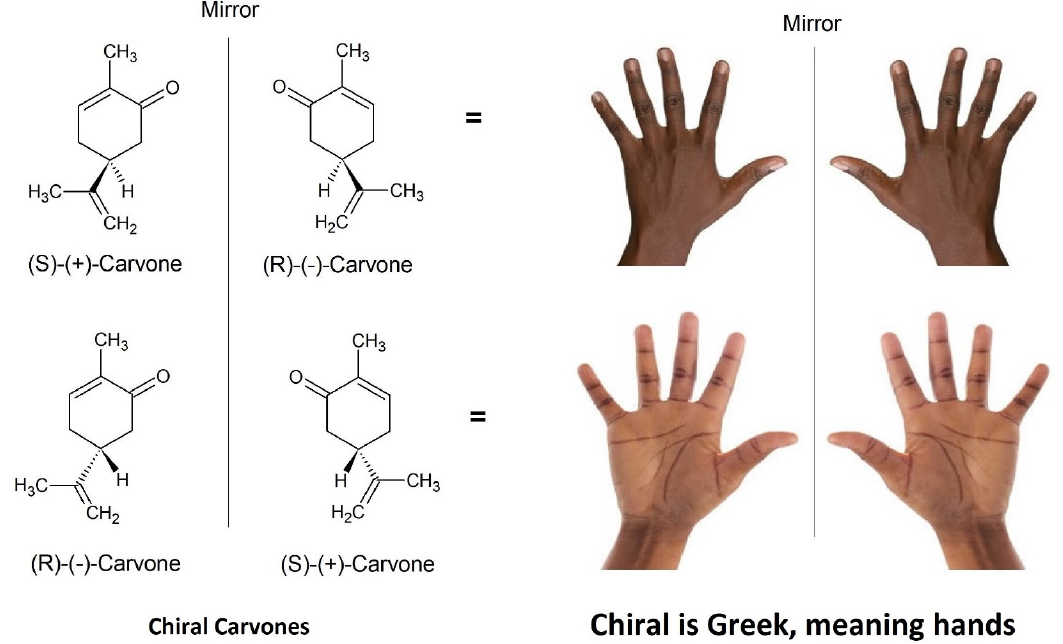
Figure 13. Chirality is also known as hands. Carvone is an example of a chiral compound that has only one chiral